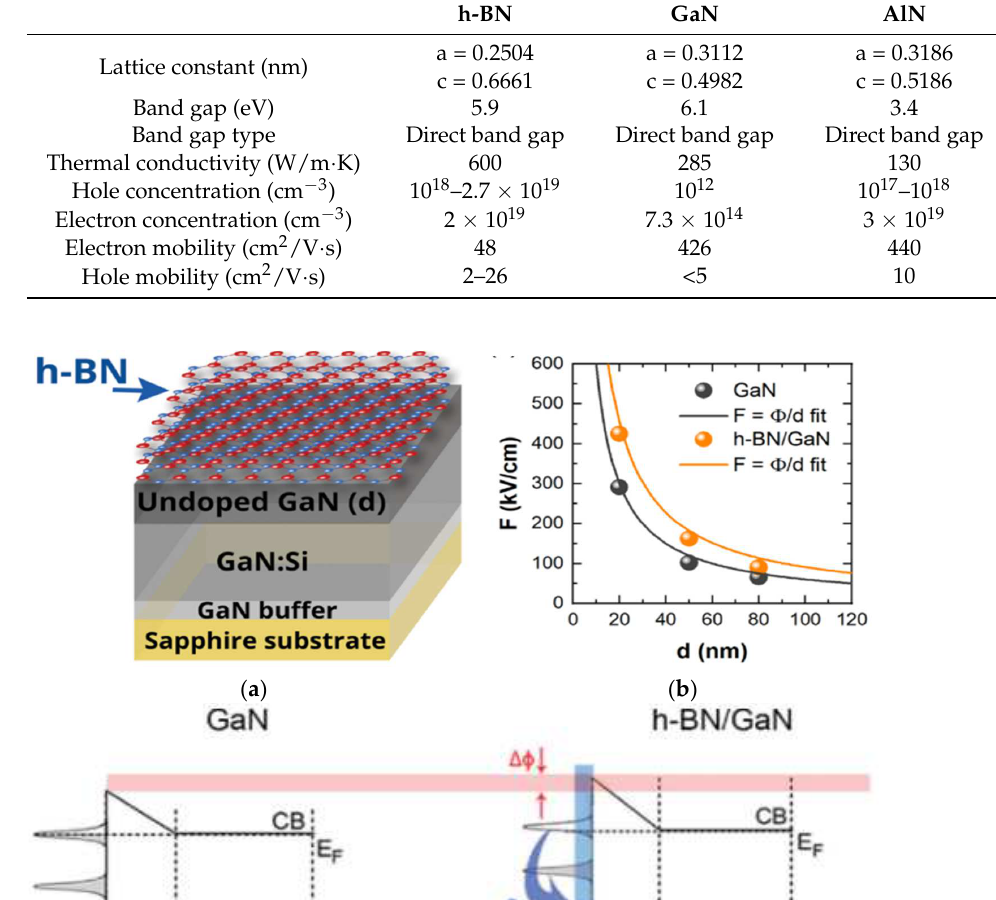
Table 3. Comparison of h-BN with GaN and AlN [33].